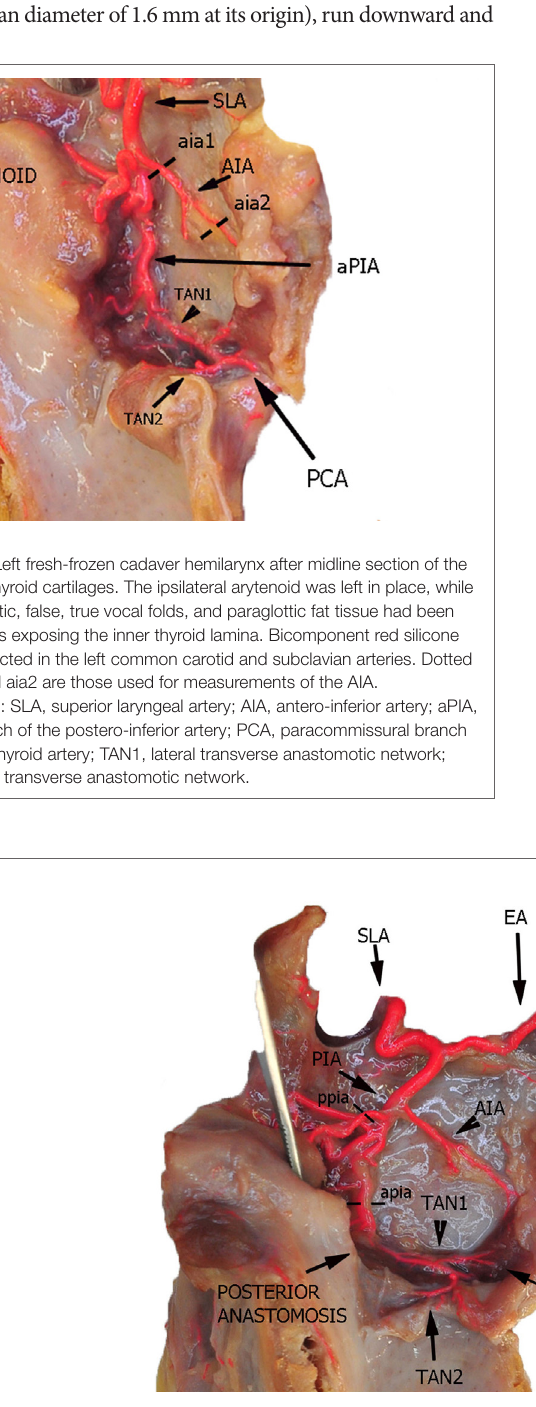
Figure 3 | Left fresh-frozen cadaver hemilarynx after midline section of the cricoid and thyroid cartilages and partial separation of the contralateral hemilarynx. The ipsilateral arytenoid, as well as the epiglottis, was left in place and a metallic stick inserted into the piriform sinus, while left aryepiglottic, false, true vocal folds, and paraglottic fat tissue had been removed, thus exposing the inner thyroid lamina. Bicomponent red silicone had been injected in the left common carotid and subclavian arteries. Dotted line ppia was used for measurement of the posterior branch of the PIA, while dotted line apia represents the landmark used for measurement of its anterior branch. Abbreviations: SLA, superior laryngeal artery; AIA, antero-inferior artery; PIA, postero-inferior artery; PCA, paracommissural branch of the crico–thyroid artery; TAN1, lateral transverse anastomotic network; TAN2, medial transverse anastomotic